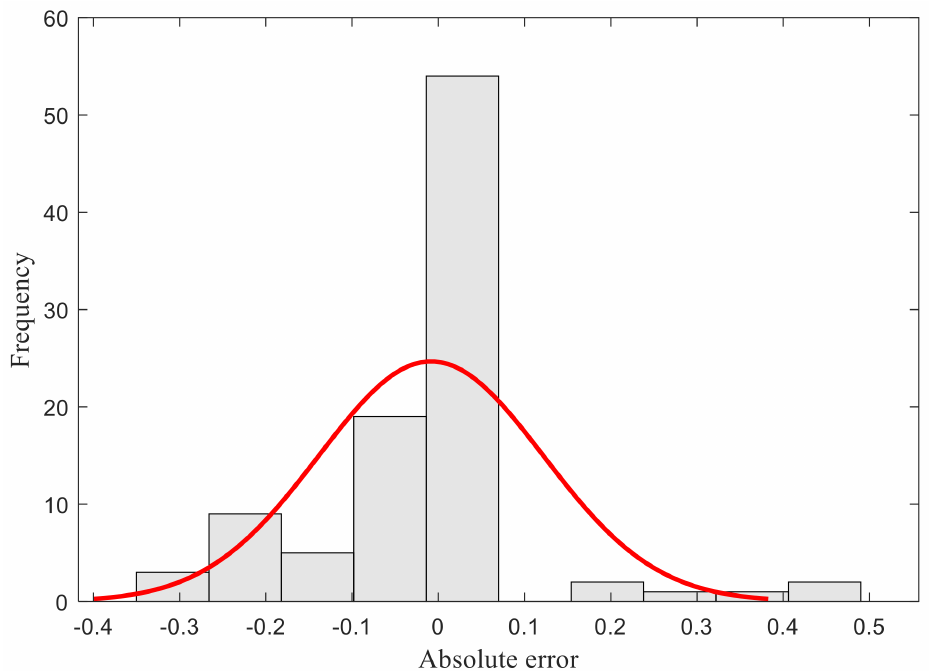
Figure 11. Histogram of residuals for the instantaneous gas injection